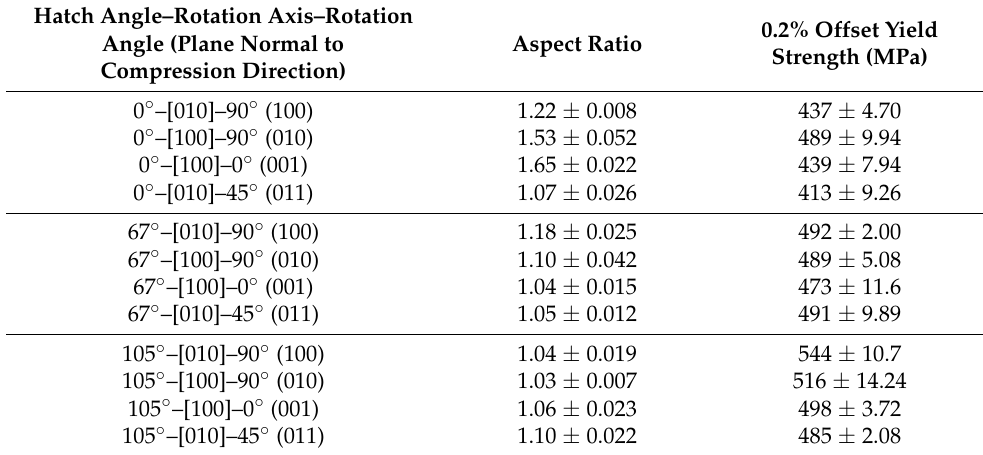
Table 3. Compression test results (yield strength and aspect